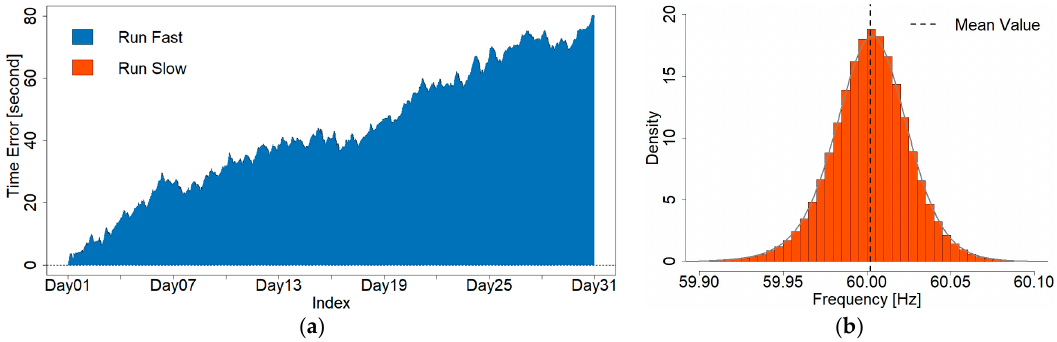
Figure 11. Time error change over one month in Itajubá, Brazil. ( a ) Time-series curve of time error in October 2016; ( b ) Probabilistic distribution function of the system frequency in one month. The blue color presents the fast time error. The orange color indicates the slow time error. The grey line shows the estimated probability density of power grid frequency. The vertical dashed line presents the average frequency of this month.